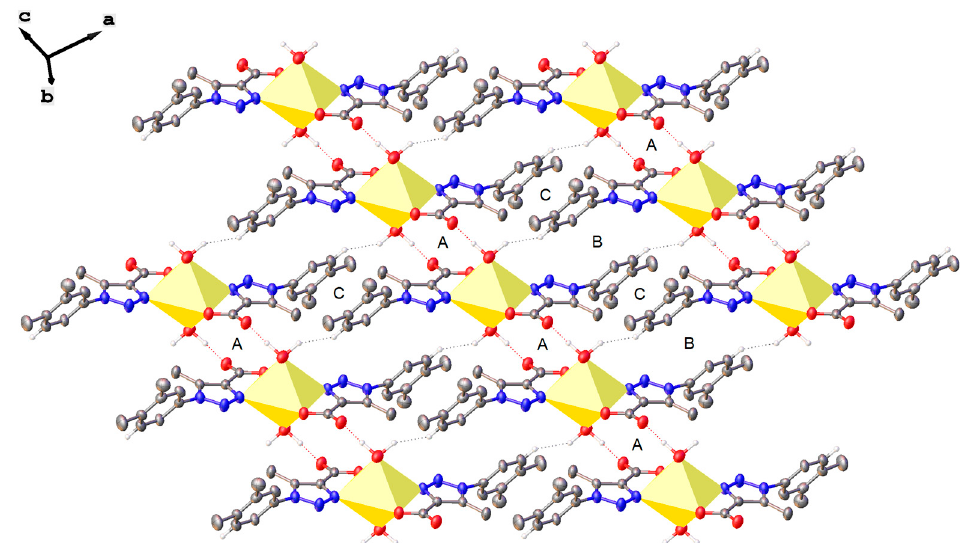
Figure 3. A view of the two-dimensional supramolecular aggregate in compounds 1 and 2 showing the formation of R 2 (12), R 2 (26), and R 2 (24) rings (labeled A, B, and C, respectively). H atoms not directly involved in hydrogen bonds have been omitted for the sake of clarity. Table 2. Contributions of the principal intermolecular contacts (%) in compounds 1 and 2 .